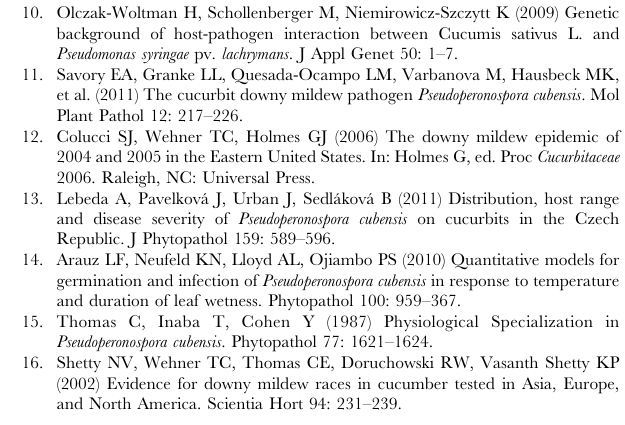
Figure S1 Concordance of expression values in two biological replicates of Cucumis sativus during infection by Pseudoperonospora cubensis . Reads from different time points were mapped to the C. sativus genome using Bowtie version 0.12.5 [57] and TopHat version 1.2.0 [56]. Fragments per kilobase pair of exon model per million fragments mapped (FPKM) values were calculated using Cufflinks version 0.9.3 [58] and the C. sativus genome annotations. For each time point, log2 transformed FPKM values of equal number of genes from both replicates are plotted. R 2 , correlation coefficient; dpi, days post- inoculation. Figure S2 Trend plots for all 11 modules. All 11 modules generated using WGCNA are shown (Modules A through K). The number of genes in each module is shown in parentheses. Table S1 List of Cucumis sativus genes expressed following infection with Pseudoperonospora cubensis .